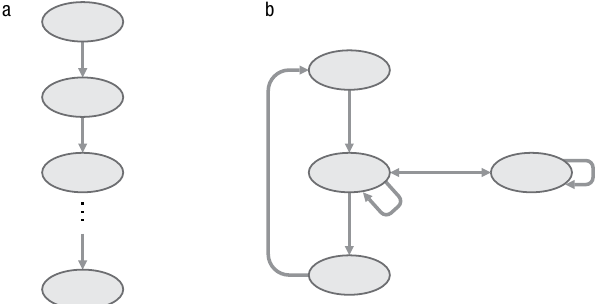
Fig. 1. The difference between a hierarchy (a) and a network